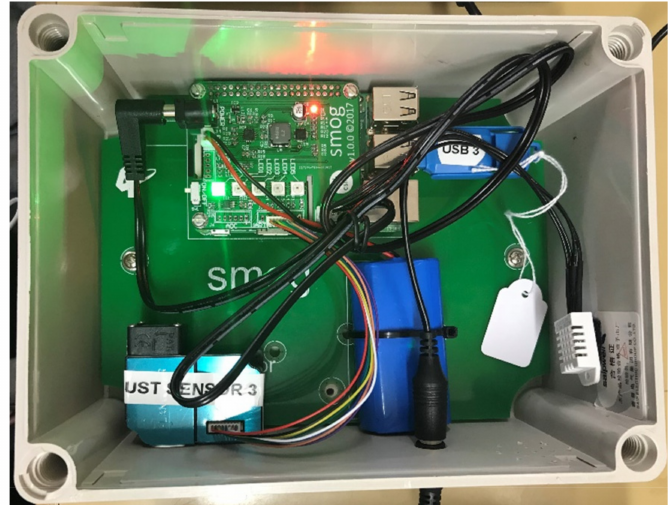
Figure 1. Assembled Smoke Observation Gadget